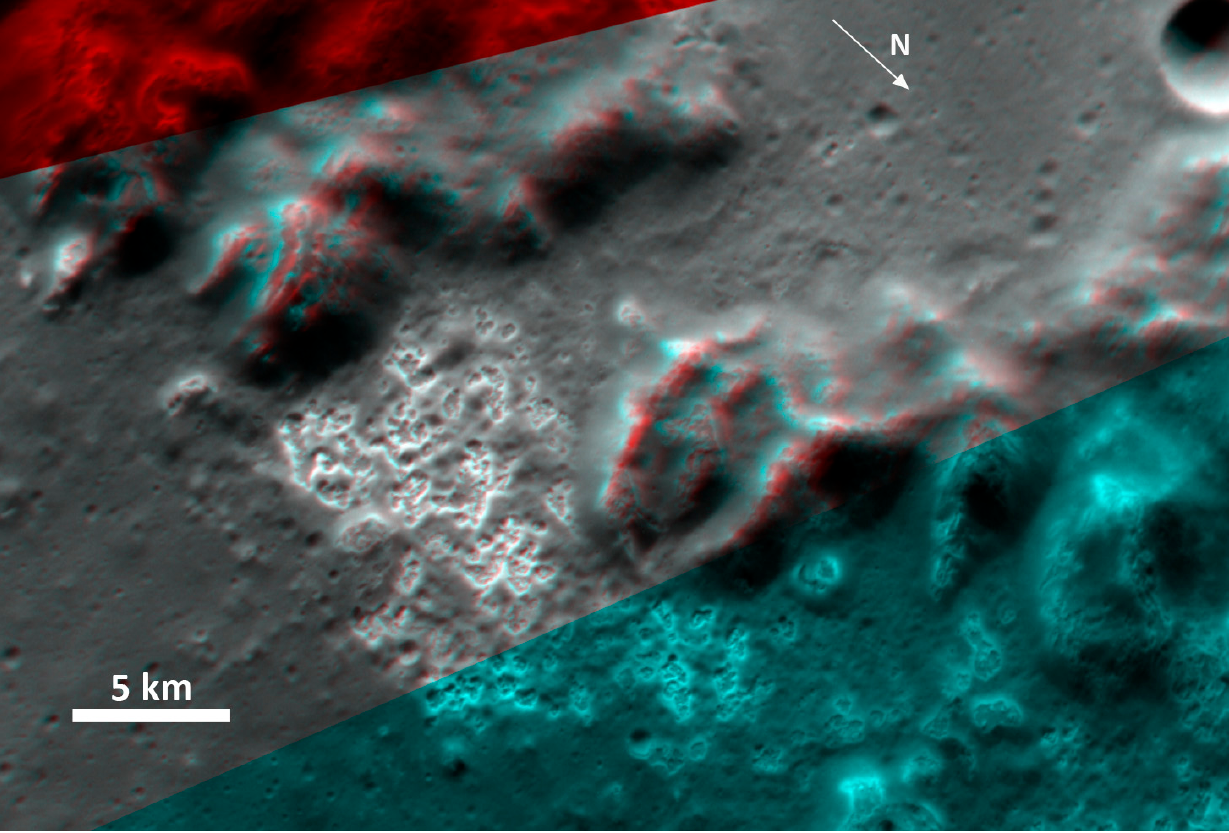
Figure A12. Raditladi Basin. Images: EN1015426008M, EN1015425734M.